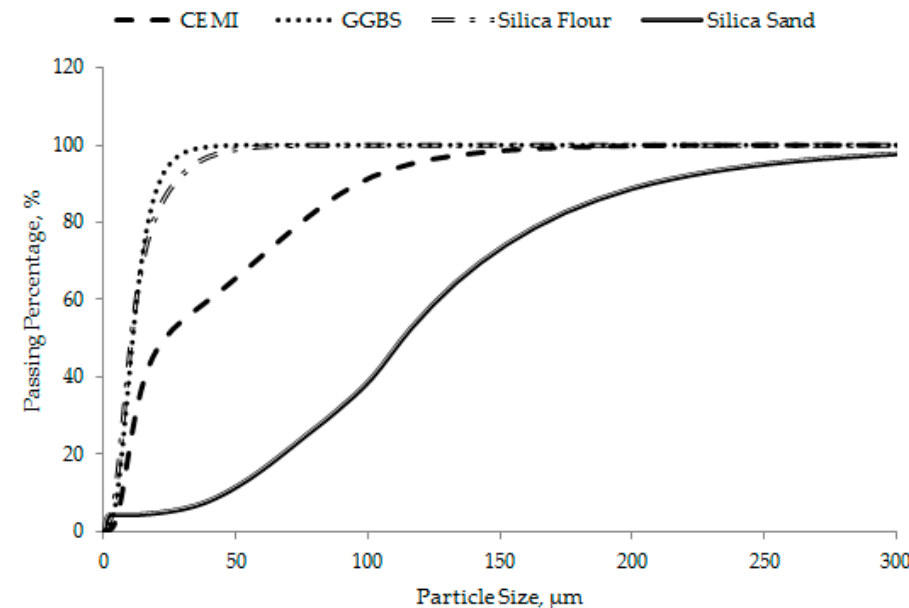
Figure 1. Particle size distribution of different ingredients used in different concrete mixes.